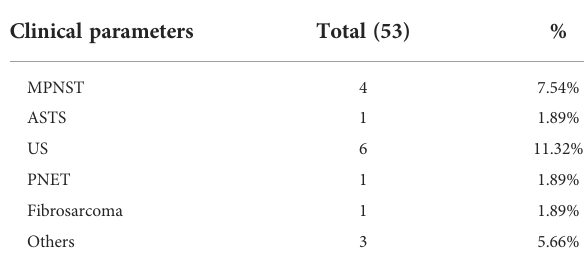
TABLE 1 Clinicopathological features of visceral